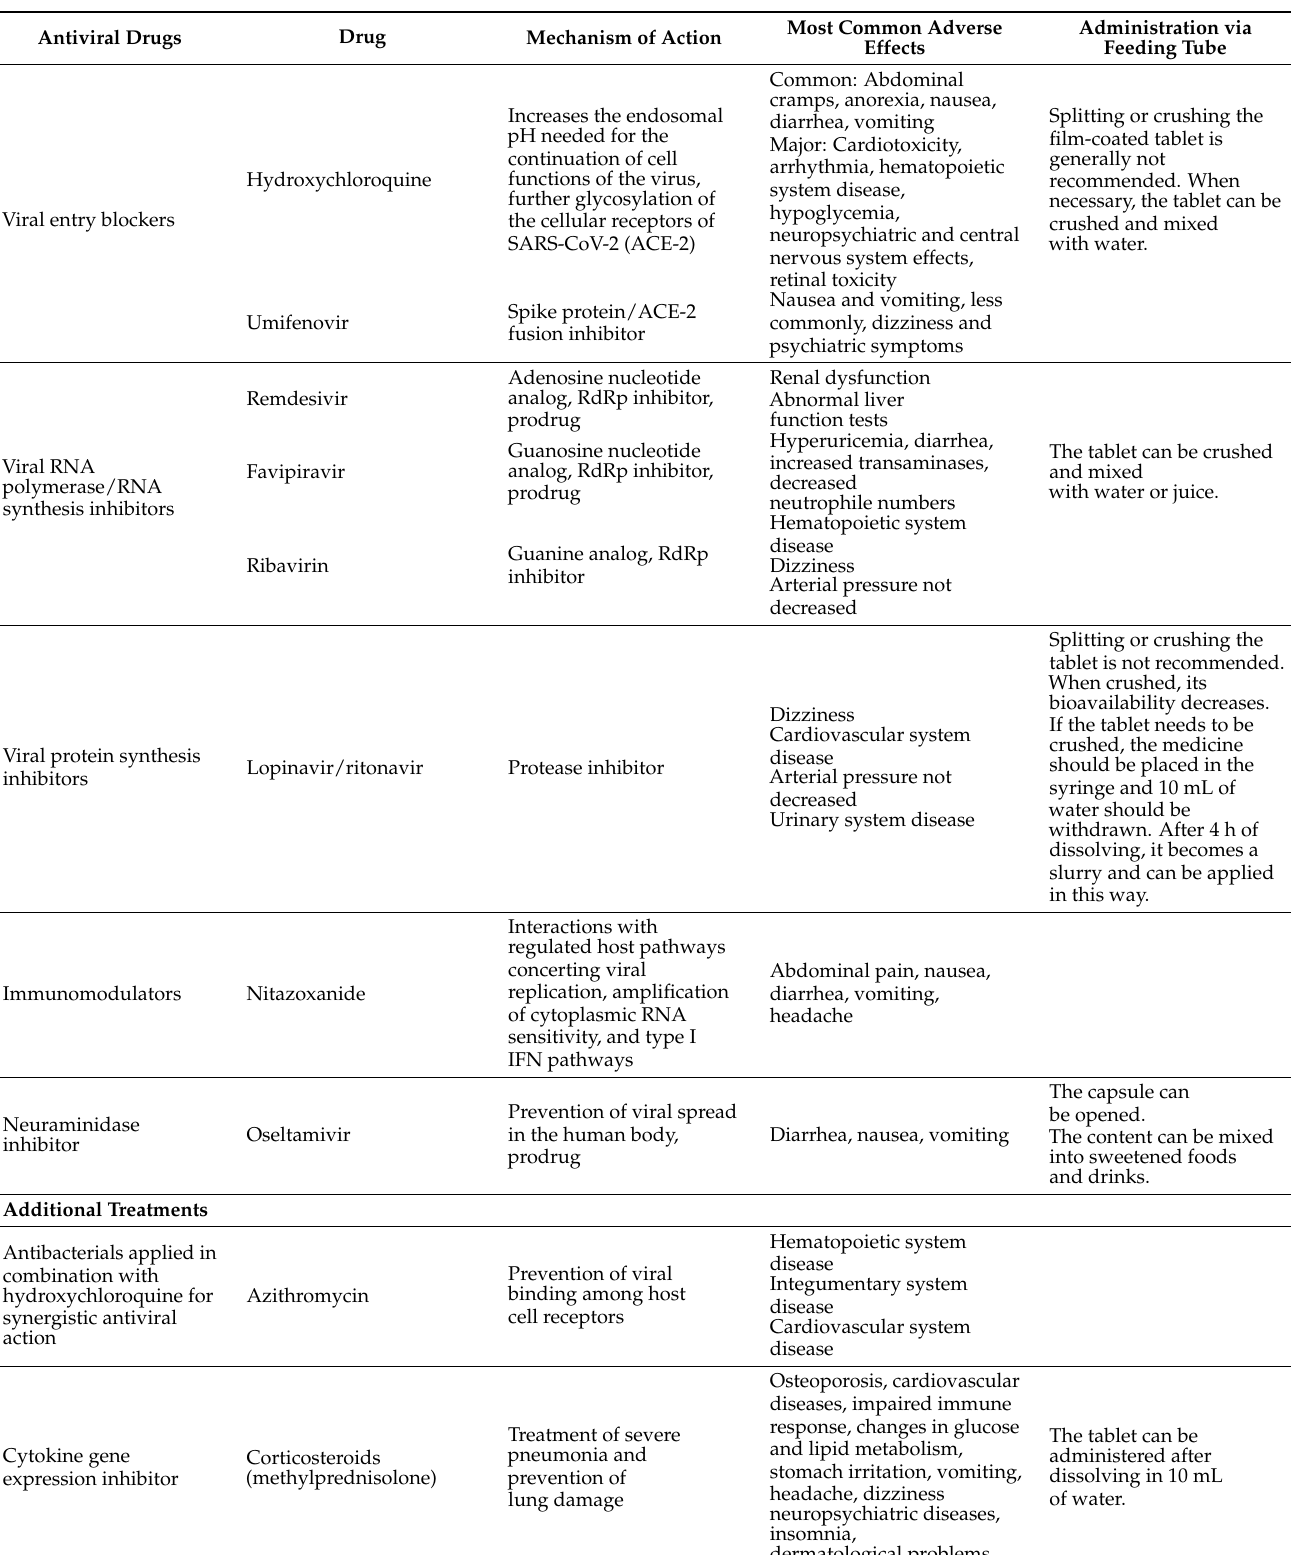
Table 1. Antiviral drugs, their mechanisms of actions, some adverse effects, and recommendations for administrations in treating COVID-19 infections